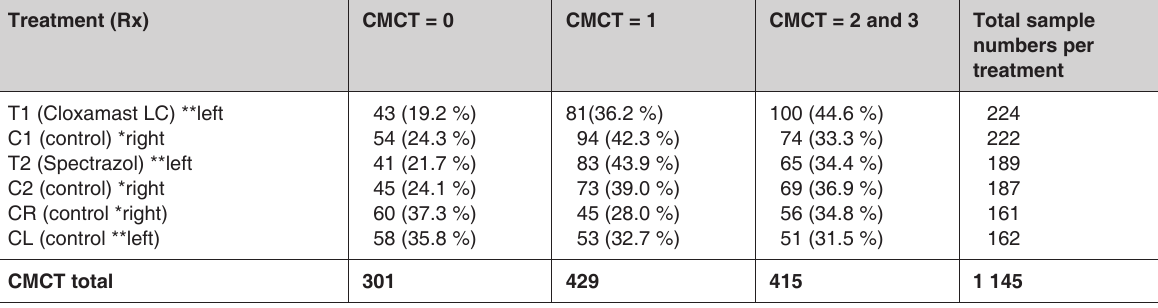
CMCT total 301 The Chi-square test performed on the data in the table above was significant ( χ 2 = 34.228; P < 0.001; degrees of freedom = 10) * Right udder half ** Left udder